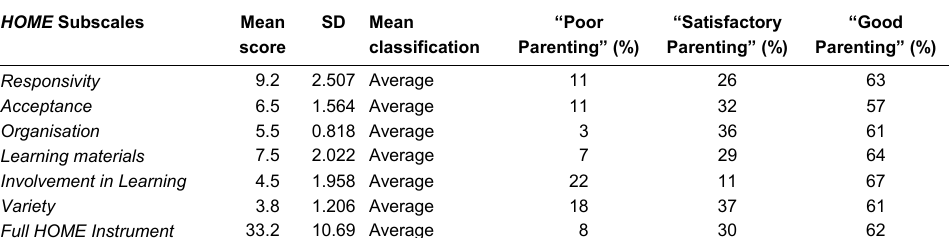
Table 4: Scores of the parent sub-sample on the HOME observation schedule